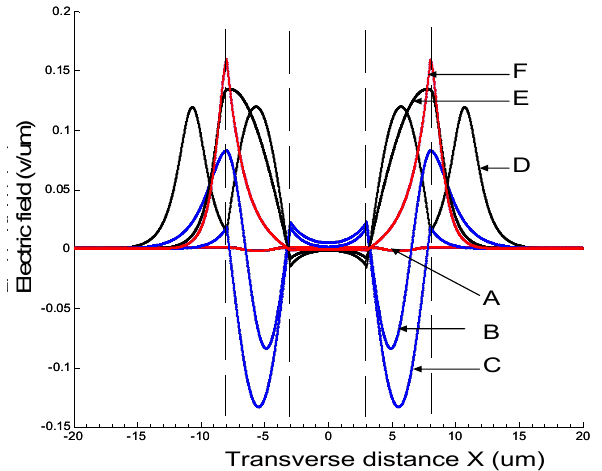
Figure 9. The electric field distribution with respect to the six points, A, B, C, D, E, and F, as shown in Figure 8.